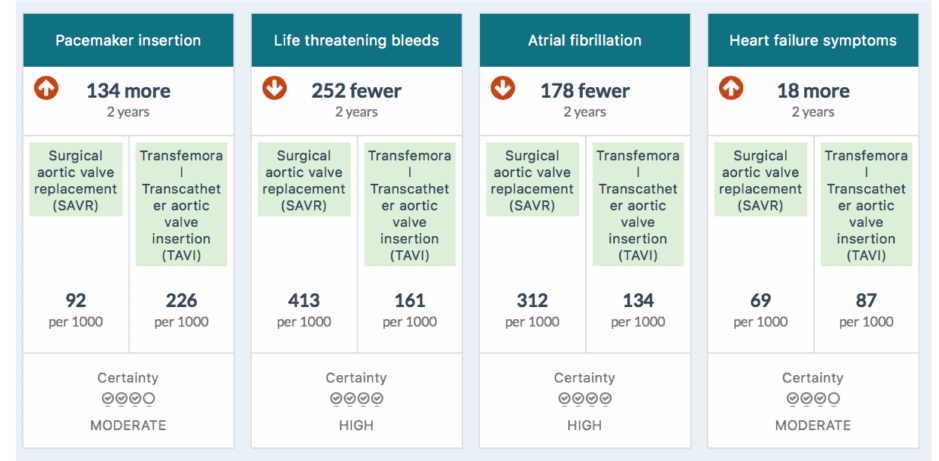
Figure 2. Information boxes in the MAGIC aid for